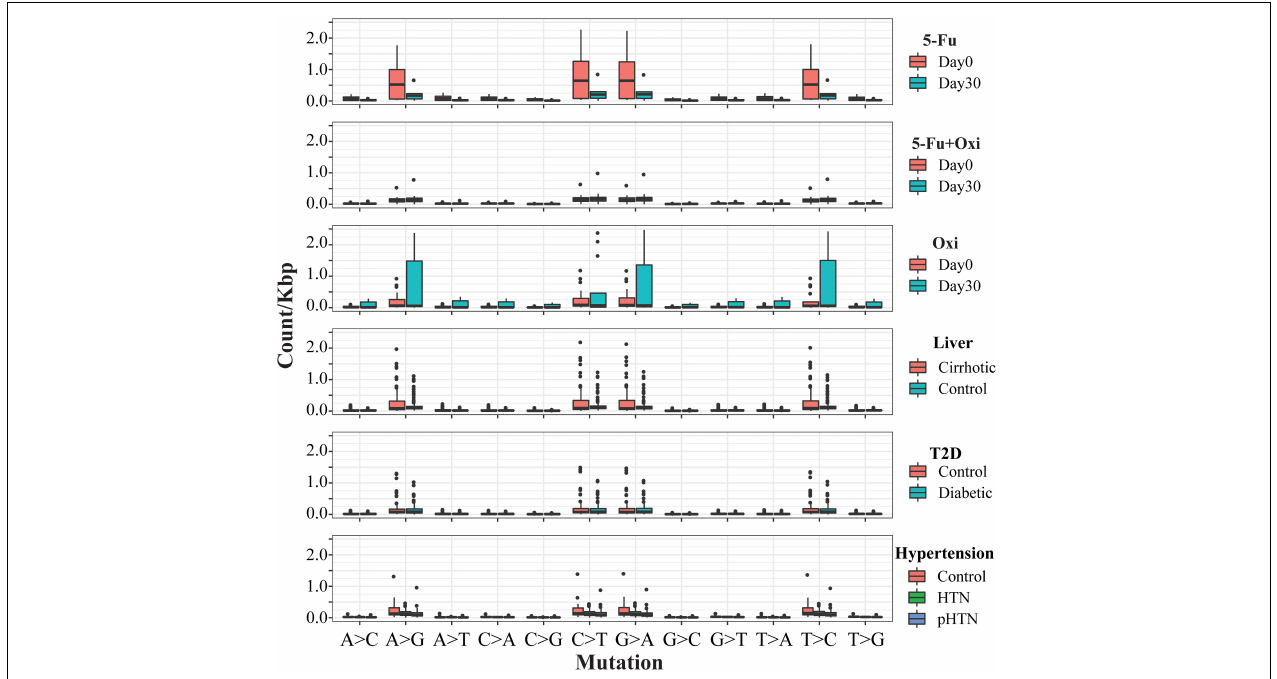
FIGURE 3 | Mutational signatures found in all fecal samples. Each cohort is displayed according to the 12 substitutions. The different groups are displayed in different colors as the legends show. The mutation types are on the horizontal axes, whereas vertical axes depict the number of mutations detected in the kilobase attributed to a specific mutation